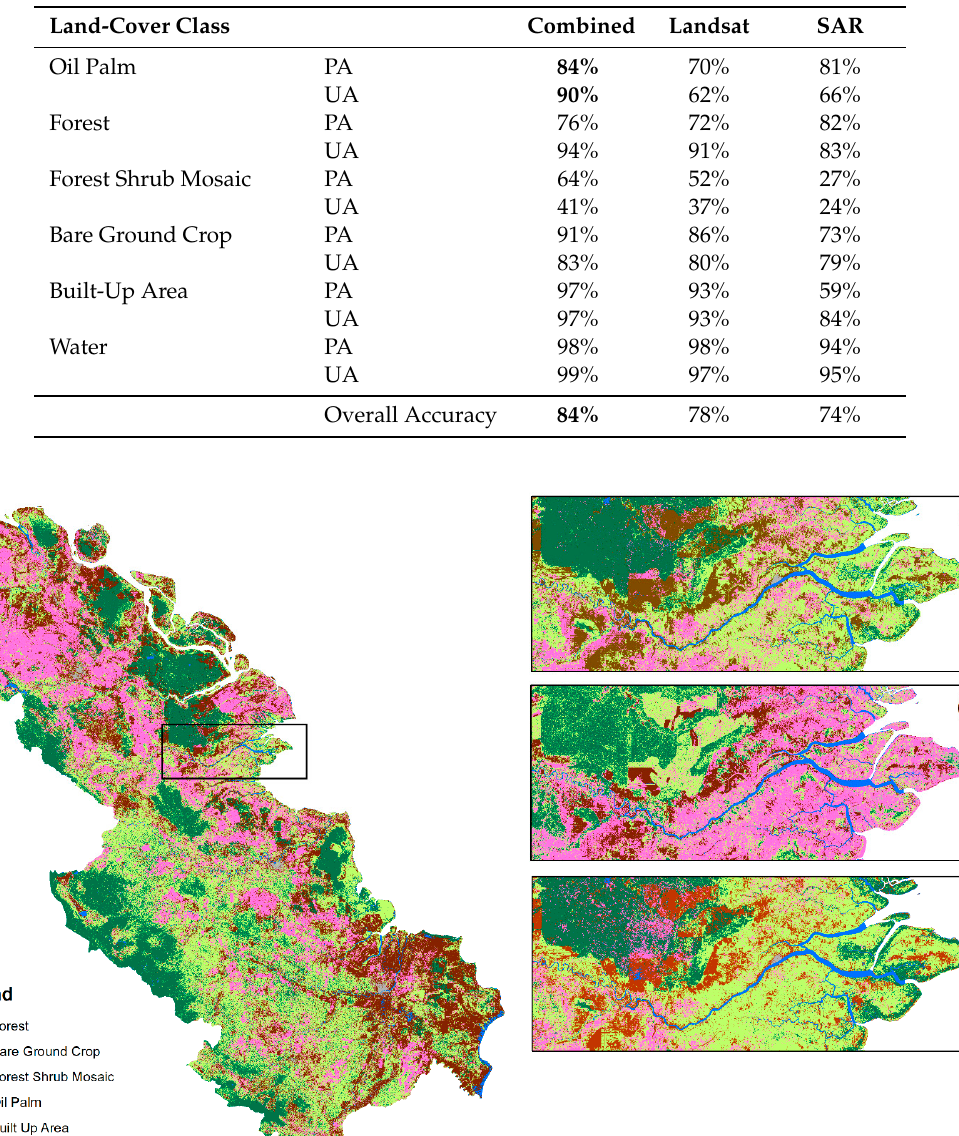
Figure 4. Error matrices of the three classifications for Landsat, SAR, and Combined maps. Values in each cell represent the number of testing pixels for each land-cover class. 3.2. Comparing Oil Palm Extents with Miettinen2016 and Austin2017 The extent of oil palm mapped in our Combined classified image for Riau, Jambi, and South Sumatra was 4,418,176 ha, which was 8.6% higher than the oil palm extent from the Indonesian Ministry of Tree Crop Statistics (4,067,358 ha) for the year 2015 [5]. Our mapped extent of oil palm was 47% higher than the extent of oil palm mapped by Miettinen2016 (2,997,943 ha) and 22% higher than the extent of oil palm mapped by Austin2017 (3,608,815 ha).